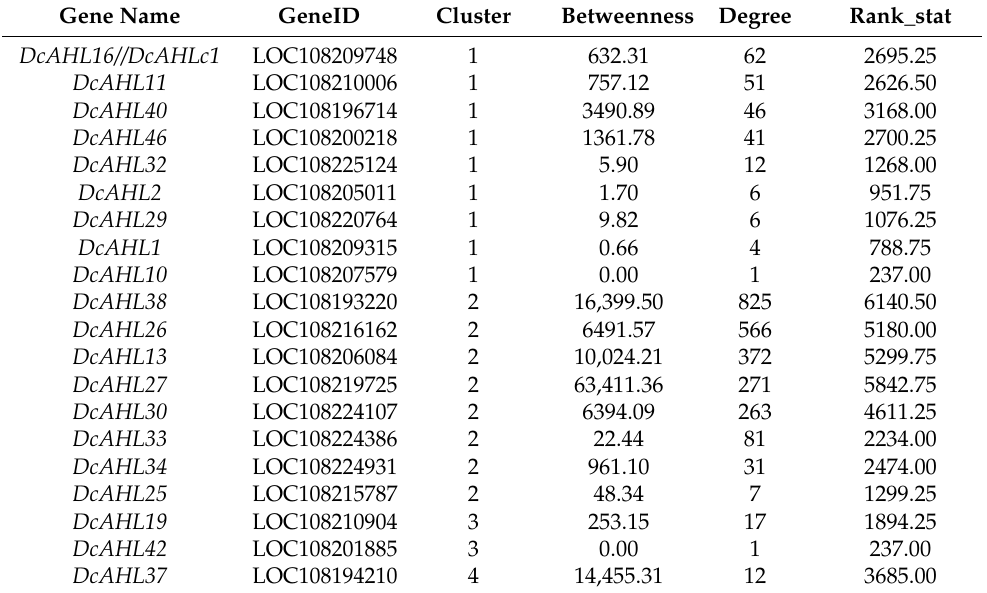
Table 2. A list of AHL genes showing significant interactions in the coexpression network analysis of genes differentially expressed in the carrot storage